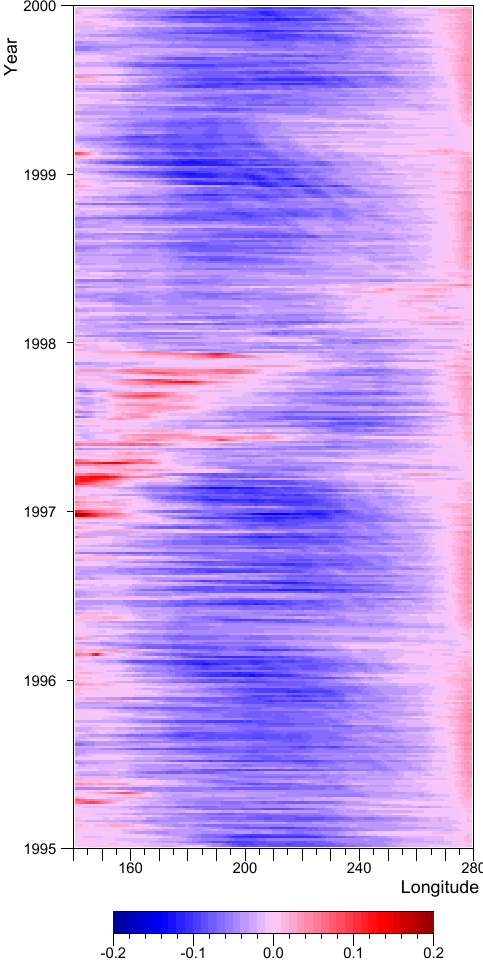
Figure 32. Eastward component of wind stress (Pa) at the Equator between 140 and 280 ◦ E (80 ◦